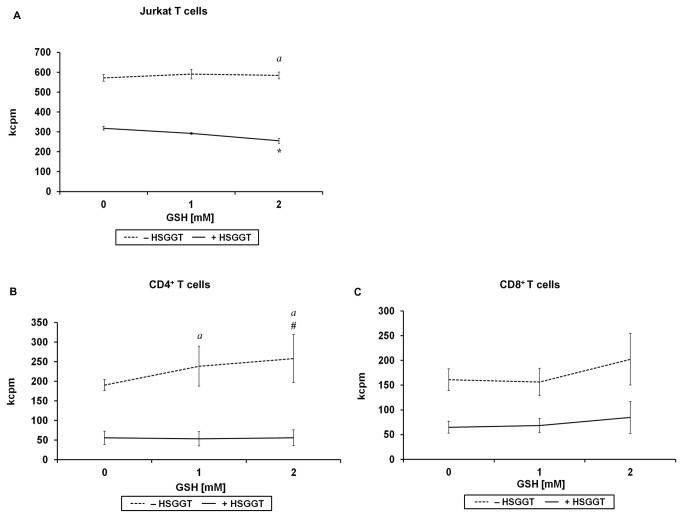
The role of GSH supplementation to H. suis γ-glutamyl transpeptidase (GGT)-treated Jurkat T cells and murine splenocytes.Jurkat T cells were incubated in medium supplemented with GSH (0 mM to 2 mM) for 72 hours (A) in the presence or absence of 2 µg/mL recombinant H. suis GGT, followed by cell proliferation detection by measuring [3H]-thymidine uptake. The mean data (± SD) of one representative experiment are shown (n=3). CD4+ T cells (B) or CD8+ T cells (C) activated by CD3/CD28 mAbs, were incubated in medium supplemented with GSH (0 mM to 2 mM) for 68 hours in the presence or absence of 1µg/mL recombinant H. suis GGT, followed by cell proliferation detection by measuring [3H]-thymidine uptake, as shown by kcpm (counts per minute; x1000) values. Shown are the mean values (± SD) of 3 independent experiments (n=9). An * indicates a decrease of cell proliferation of H. suis GGT-treated cells supplemented by a given GSH concentration, compared to H. suis GGT treated cells without GSH supplementation (0 mM GSH) (one-way ANOVA). An # indicates an increase of cell proliferation of HBSS-treated cells supplemented by a given GSH concentration, compared to HBSS-treated cells without GSH supplementation (0 mM GSH) (one-way ANOVA). An (a) indicates the relative increase of the difference of cell proliferation between HBSS-treated cells and H. suis GGT-treated cells at an indicated concentration of GSH, compared to 0 mM GSH-treated cells (Student t test). *, #, and (a): p < 0.05. kcpm: the number of counts per minute (x1000) determined by β-scintillation counting, as a measure of cellular proliferation; HSGGT: recombinant H. suis GGT; CD3/CD28 mAbs: anti-mouse CD3/CD28 monoclonal antibodies; GSH: reduced glutathione; -HSGGT: treated without recombinant H. suis GGT; +HSGGT: treated with recombinant H. suis GGT.